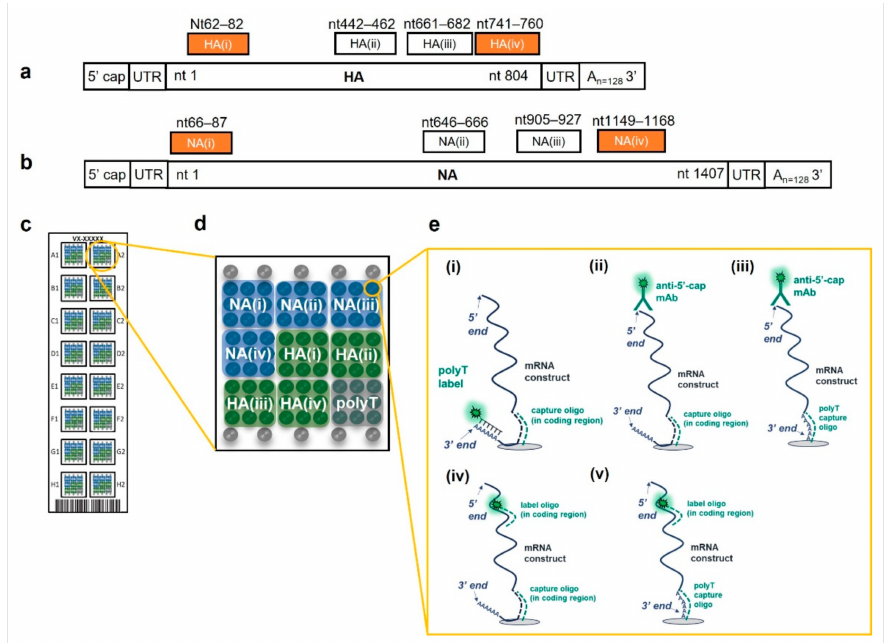
Figure 1. ( a , b ) Schematic of the HA and NA constructs used, respectively, with binding location of oligonucleotide captures shown above each construct. Captures shown in orange were the focus of performance assessment ( c ) Schematic representation of the VaxArray mRNA microarray slide showing 16 replicate microarrays, ( d ) individual microarray layout showing 9 replicate spots for each capture oligo, and fiducial markers in grey in top and bottom rows, ( e ) assay detection schemes represented herein, namely (i) coding region capture and polyT labeling, (ii) coding region capture and 5 (cid:48) cap labeling, (iii) polyT capture and 5 (cid:48) cap labeling, (iv) coding region capture and coding region labeling, and (v) polyT capture and coding region